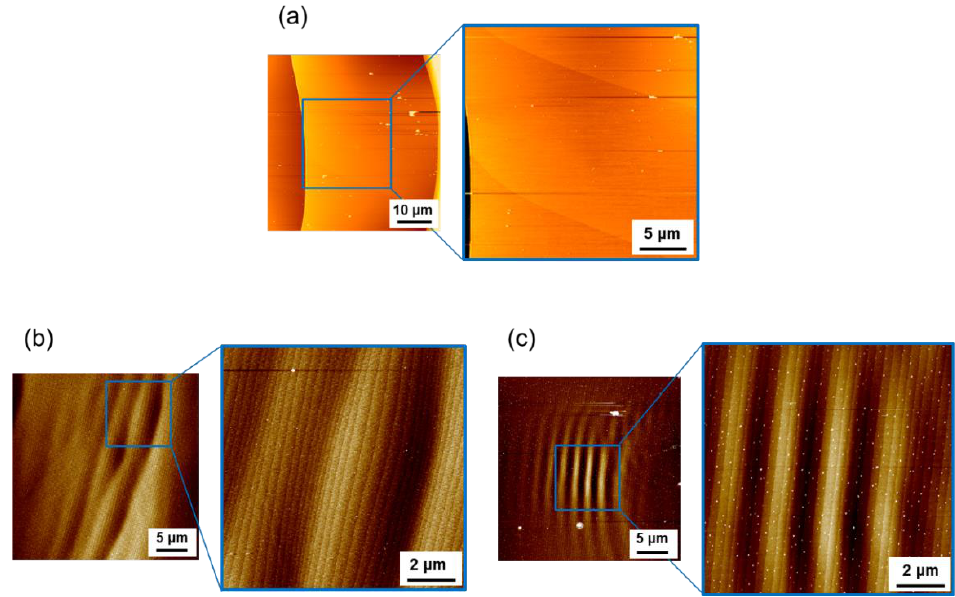
Figure 4. AFM images of the step structures observed at ( a ) Point A’, ( b ) Point B’, and ( c ) Point C’ in the central region (near a spiral growth center) of the (0001) facet of boules A, B, and C, respectively, shown in Figure 1. In each figure, a set of wide-area AFM images (50- µ m square or 30- µ m square area) and small-area images (25- µ m square or 10- µ m square area) are shown; the location of the small-area AFM image is indicated by a blue-line open square shown in the wide area image.